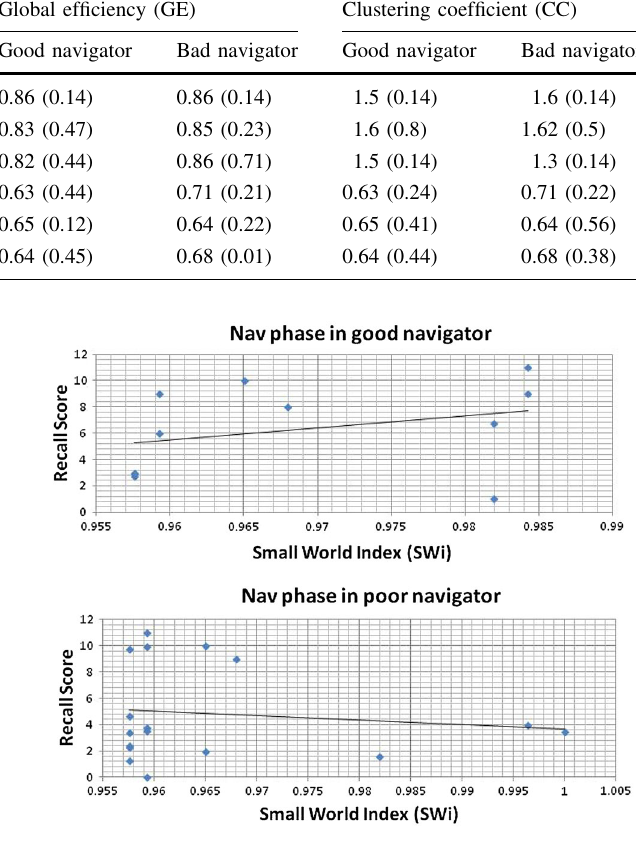
Fig. 4 Scatter plot between recall score and total percentage connectivity during Encoding phase in good navigator ( R 2 = 8%), and poor navigator ( R 2 = 2%)